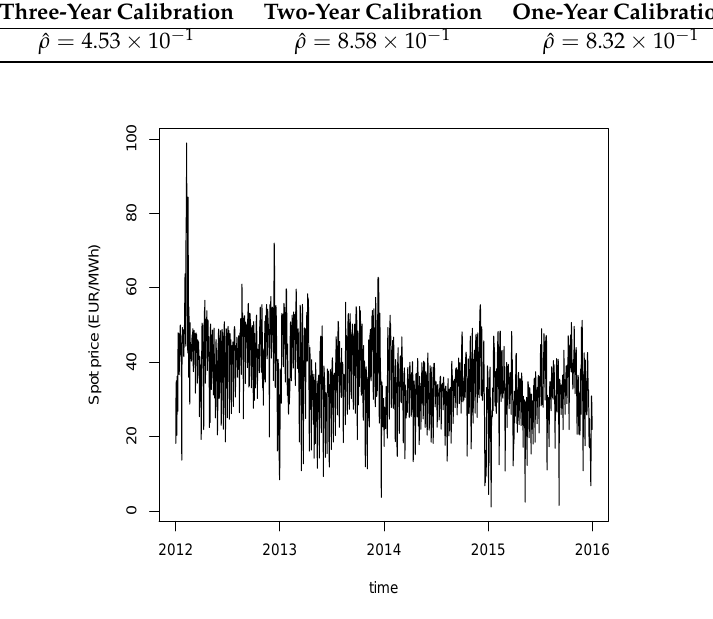
Figure 6. Spot price time